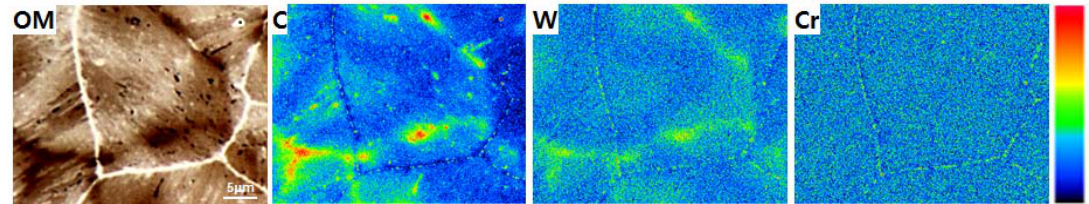
Figure 7. Electron probe microanalyzer (EPMA) mapping results showing the distribution of elements at 700 °C.